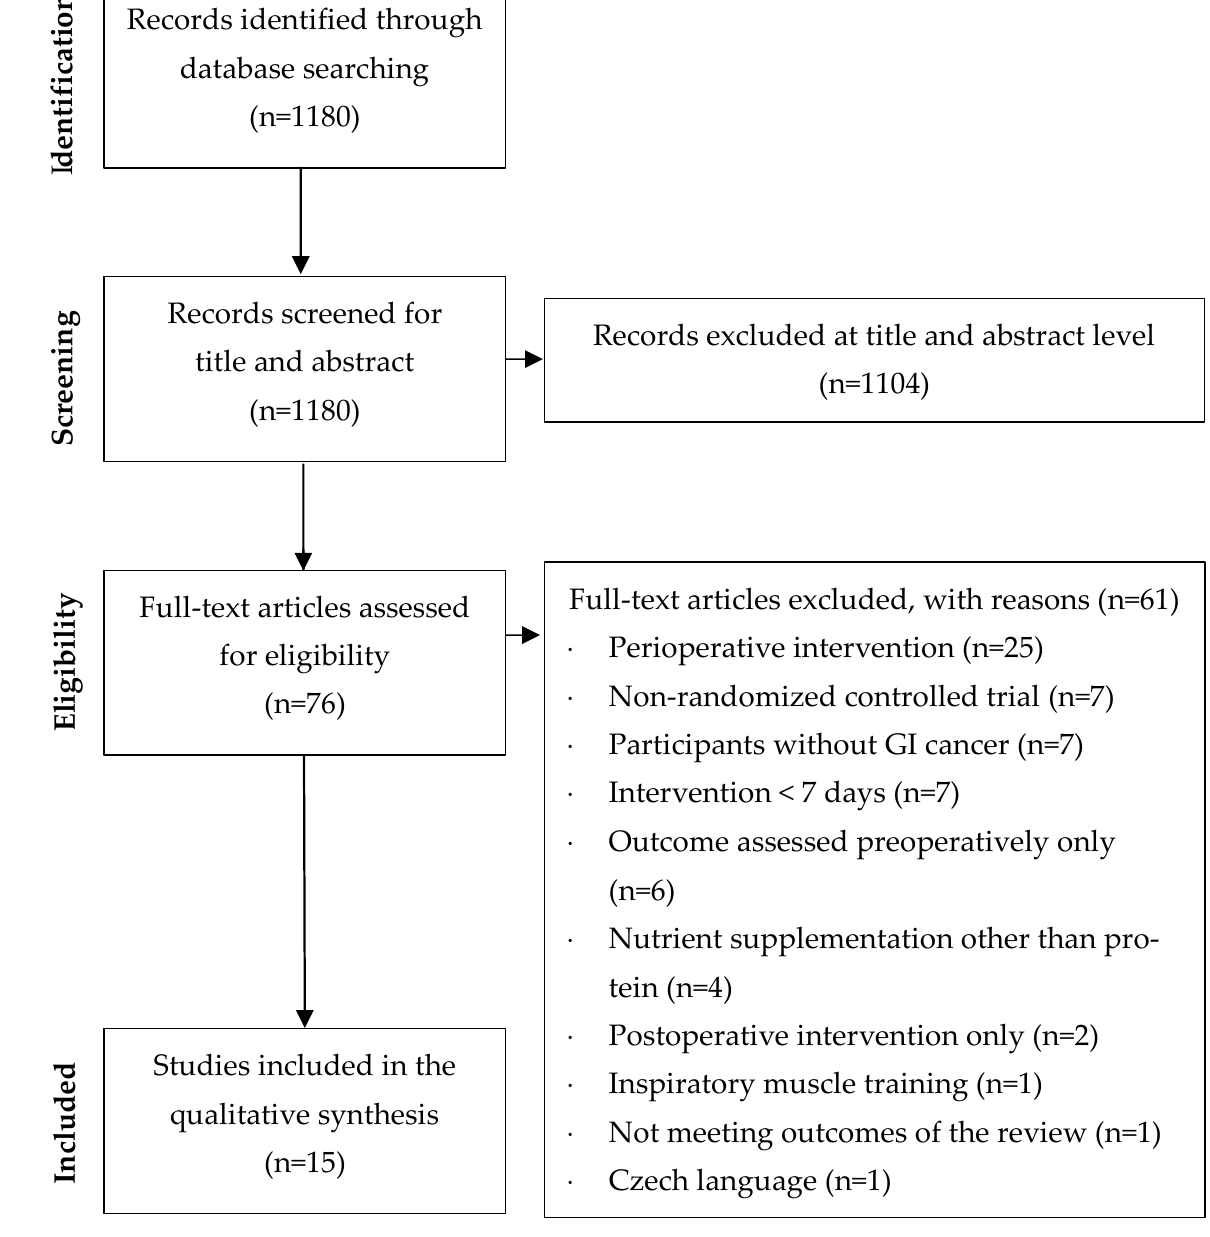
Figure 1. Flow diagram of the study selection process. Tables 1–5 detail the studies included in the systematic review. Most RCTs assessed the effects of unimodal preoperative interventions: nutrition (n = 5, Table 1), physical activity (n = 3, Table 2), and probiotics (n = 2, Table 3). Other studies combined preoperative nutritional and physical activity interventions (n = 2, Table 4) and multimodal interven- tions (>2 interventions, n = 3, Table 5). No RCT assessed the impact of fecal microbiota transplantation or oral hrelin receptor agonists as preoperative interventions. The duration of interventions varied from 1 to 15 weeks, with an intervention lasting ≤ 4 weeks in most of the studies. The modalities of interventions differed significantly among studies. Finally, postoperative complications were the most frequently studied outcome, followed by LOS. Muscle mass, strength, physical performance, and QoL have been scarcely